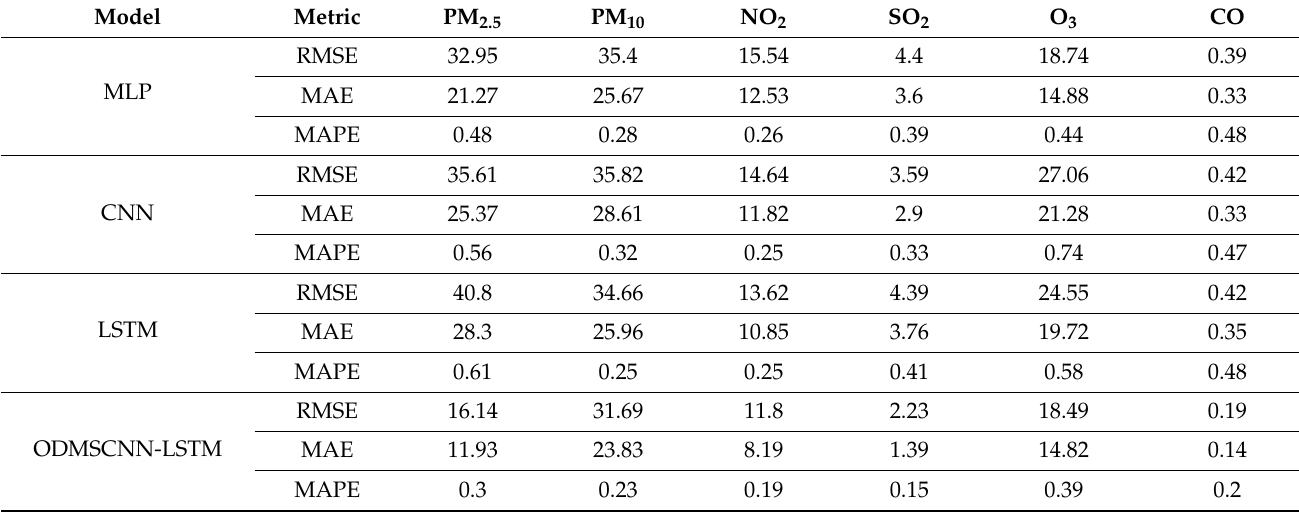
Table 2. Results of different models for daily prediction of atmospheric pollutants (RMSE, MAPE, MAE).